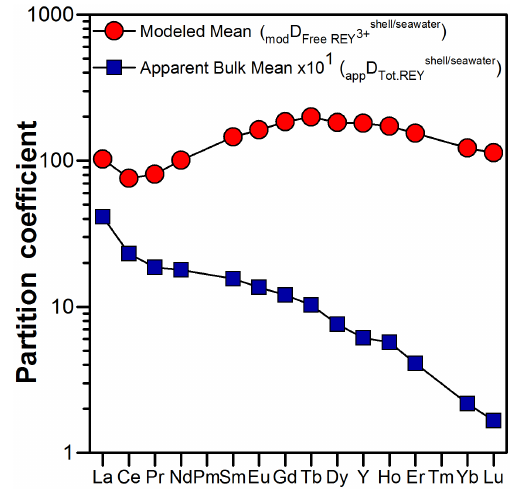
Figure 6. Mean apparent REY partition coefficients for M. edulis shells from the ODAS site and total REY in ambient seawater ) and modeled mean apparent REY partition co- ( app D shell/seawater Tot.REY efficients for M. edulis shells from the ODAS site and free REY 3 + ) in ambient seawater ( mod D shell/seawater FreeREY3+